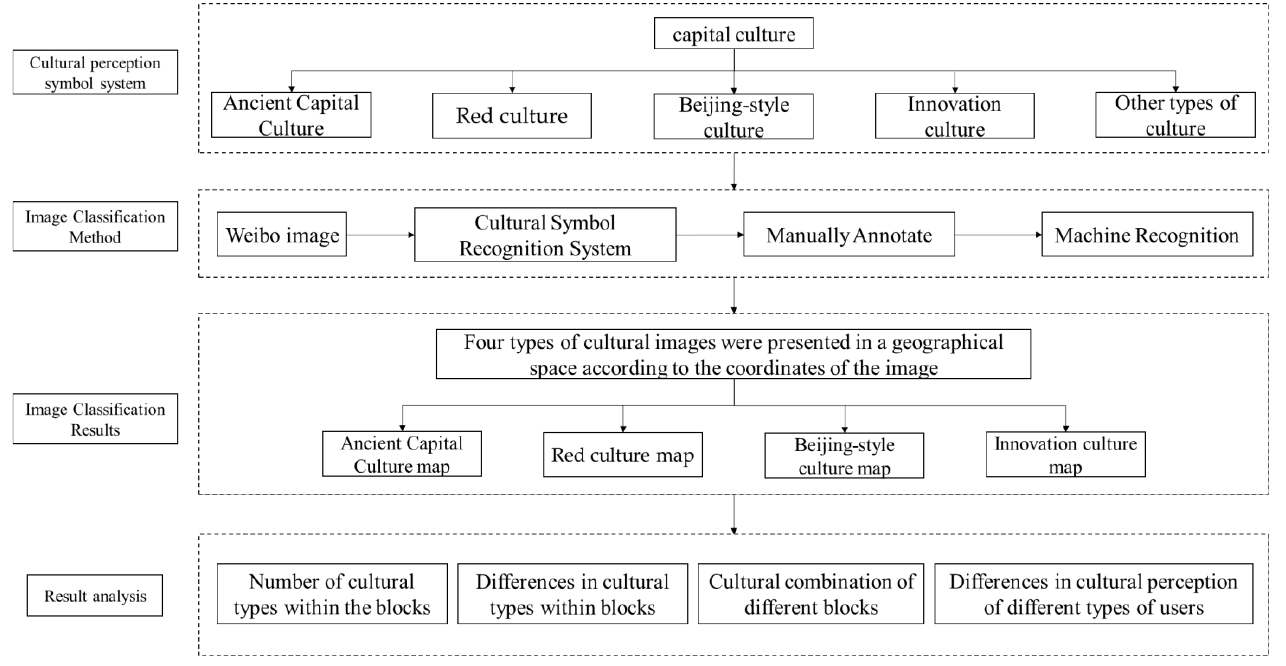
Figure 2. Study framework. Figure 2. Study Table 1. Cultural perception symbol system.